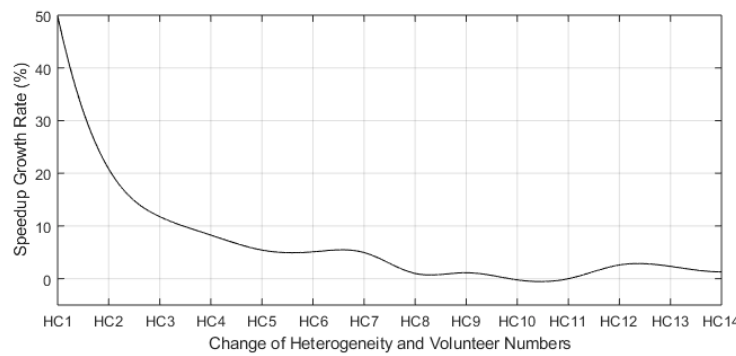
Figure 5. The speedup growth rate vs. change of evaluation pairs.